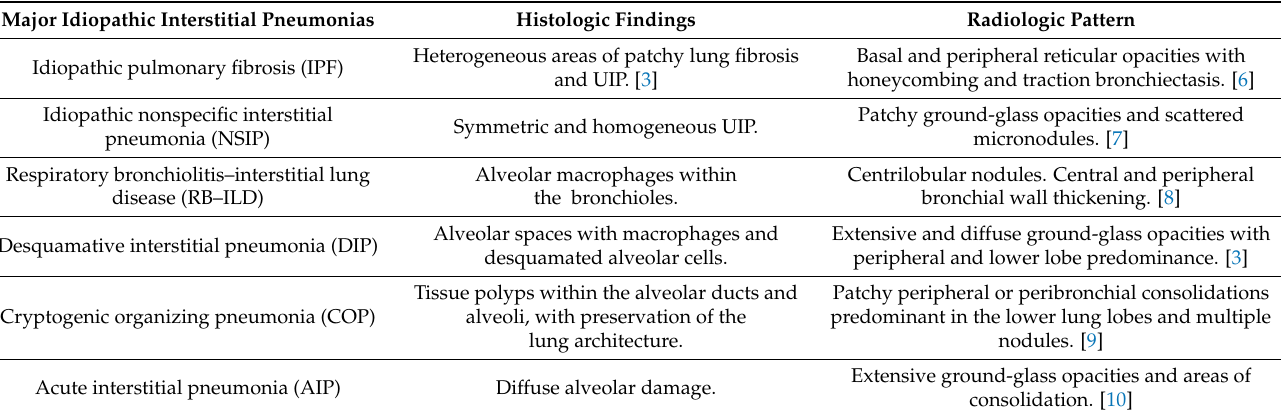
Table 1. American Thoracic Society/European Respiratory Society classification of major idiopathic interstitial pneumonias in order of relative frequency, and their principal histologic findings and radiologic patterns. Major Idiopathic Interstitial Pneumonias Histologic Findings Radiologic Pattern Idiopathic pulmonary fibrosis (IPF) Idiopathic nonspecific interstitial Symmetric and homogeneous UIP. pneumonia (NSIP) Alveolar macrophages within the